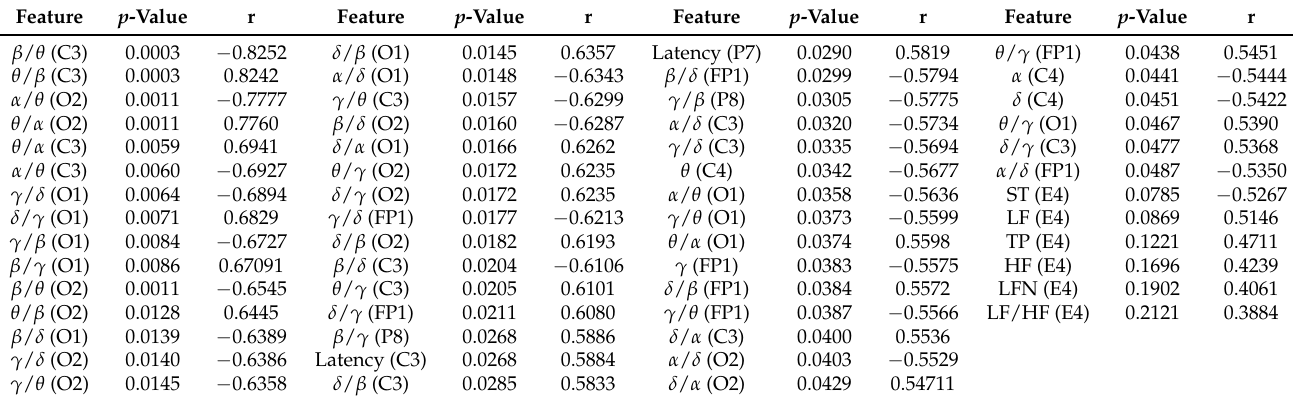
Table 2. EEG and E4 features which showed significant correlation to FAS